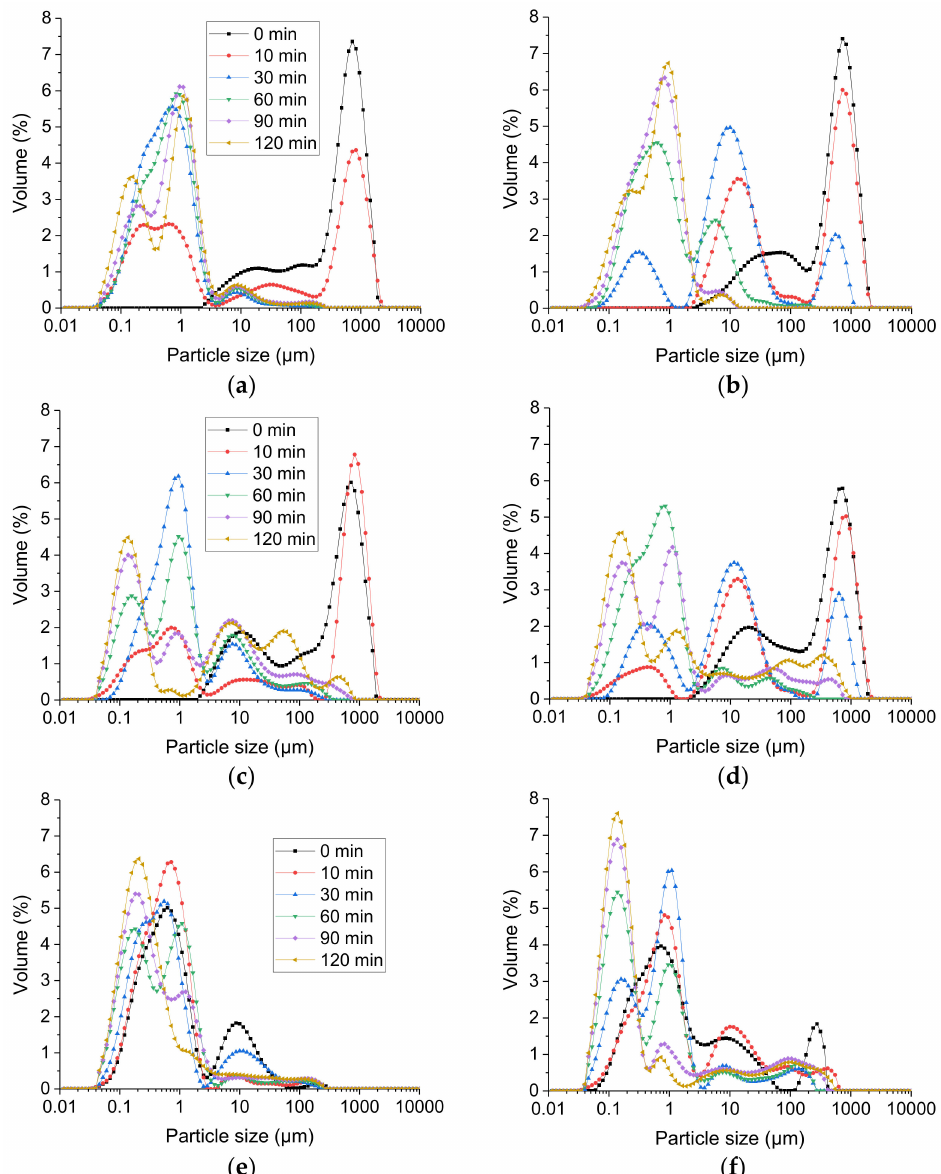
Figure 4. Changes in particle size distributions of digesta during 120 min of intestinal digestion (0, 10, 30, 60, 90 and 120 min). Gastric digesta emptied at different gastric digestion times from the soft gel and the hard gel were used for intestinal digestion: ( a ) gastric digesta from the soft gel emptied at 60 min; ( b ) gastric digesta from the hard gel emptied at 60 min; ( c ) gastric digesta from the soft gel emptied at 120 min; ( d ) gastric digesta from the hard gel emptied at 120 min; ( e ) gastric digesta from the soft gel emptied at 240 min; ( f ) gastric digesta from the hard gel emptied at 240